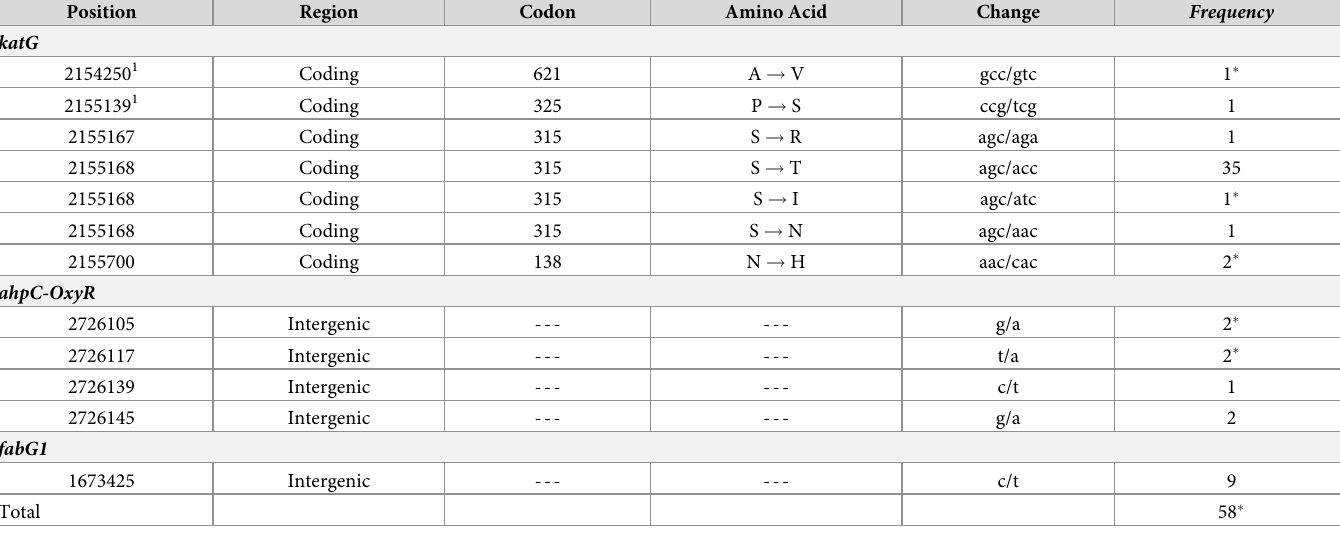
Table 1. Isoniazid mutations obtained by WGS from Mycobacterium tuberculosis isolates circulating in Veracruz, Mexico. Position